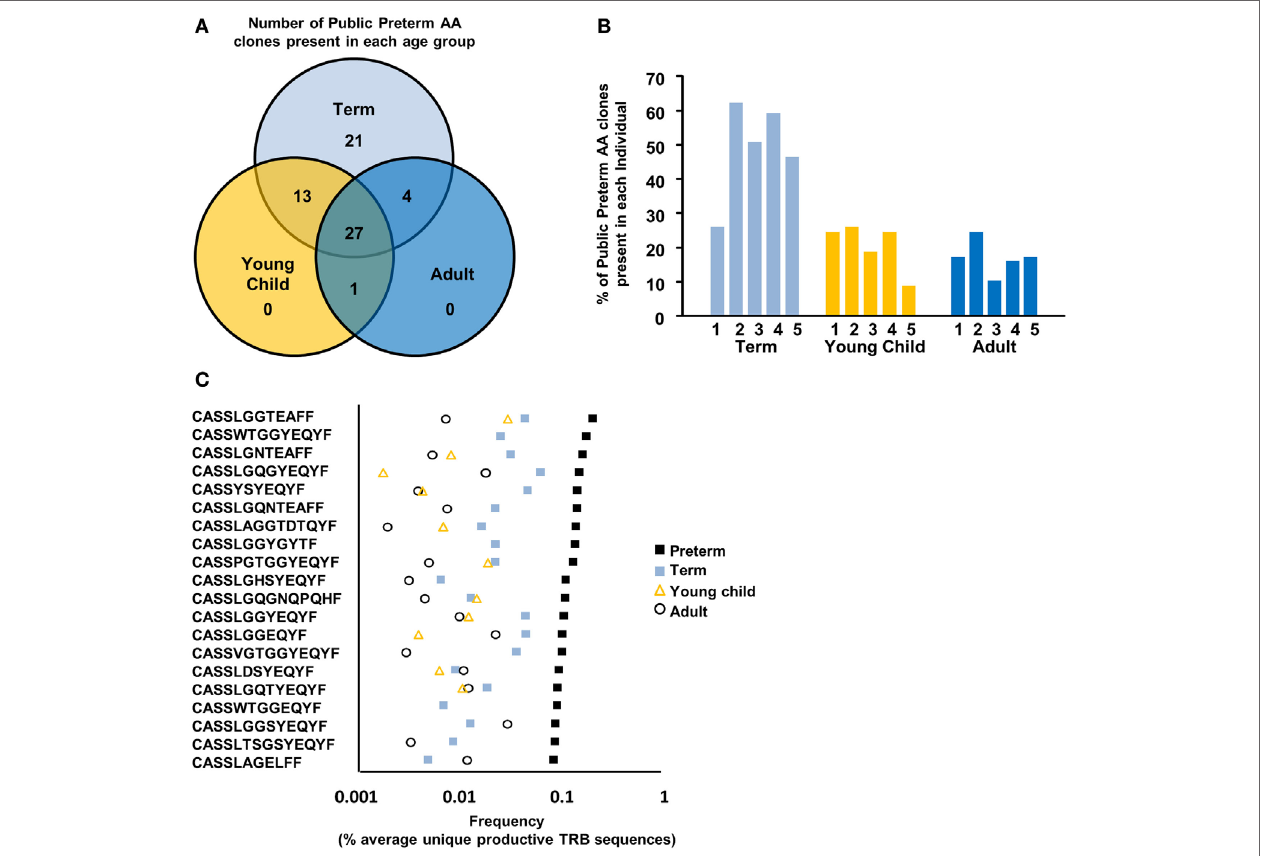
FigUre 5 | The preterm public repertoire persists across the life span. (a) The repertoires of the older age groups were queried for the presence of the 69 clones shared among all 4 preterm individuals. (B) The percentage of the 69 highly public preterm clones in each older individual is presented. (c) The repertoires of the older age groups were queried for the presence of the 20 most frequent highly shared preterm clones.